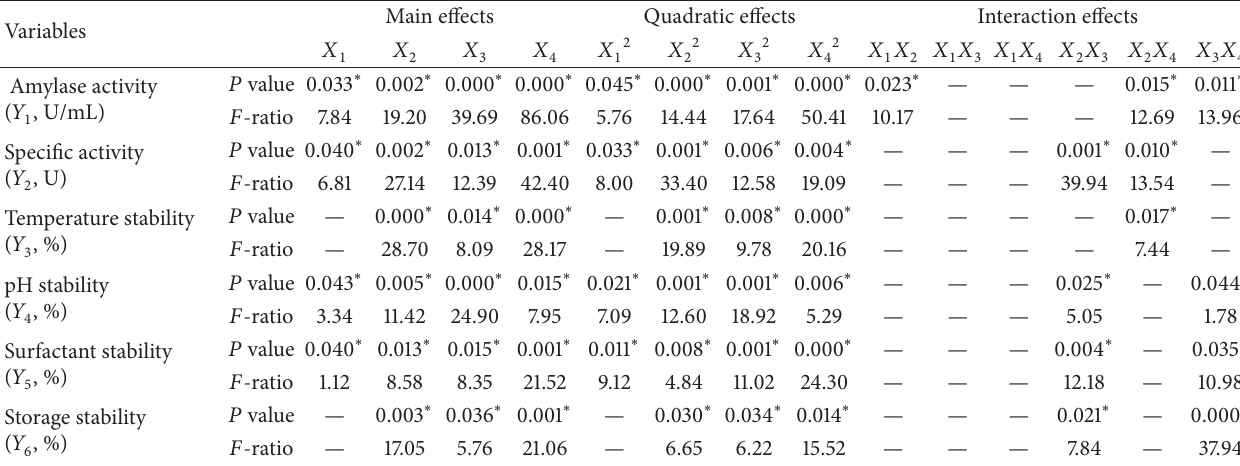
Table 2: 𝐹 -ratio and 𝑃 value for each independent variable effect in the polynomial response surface models.